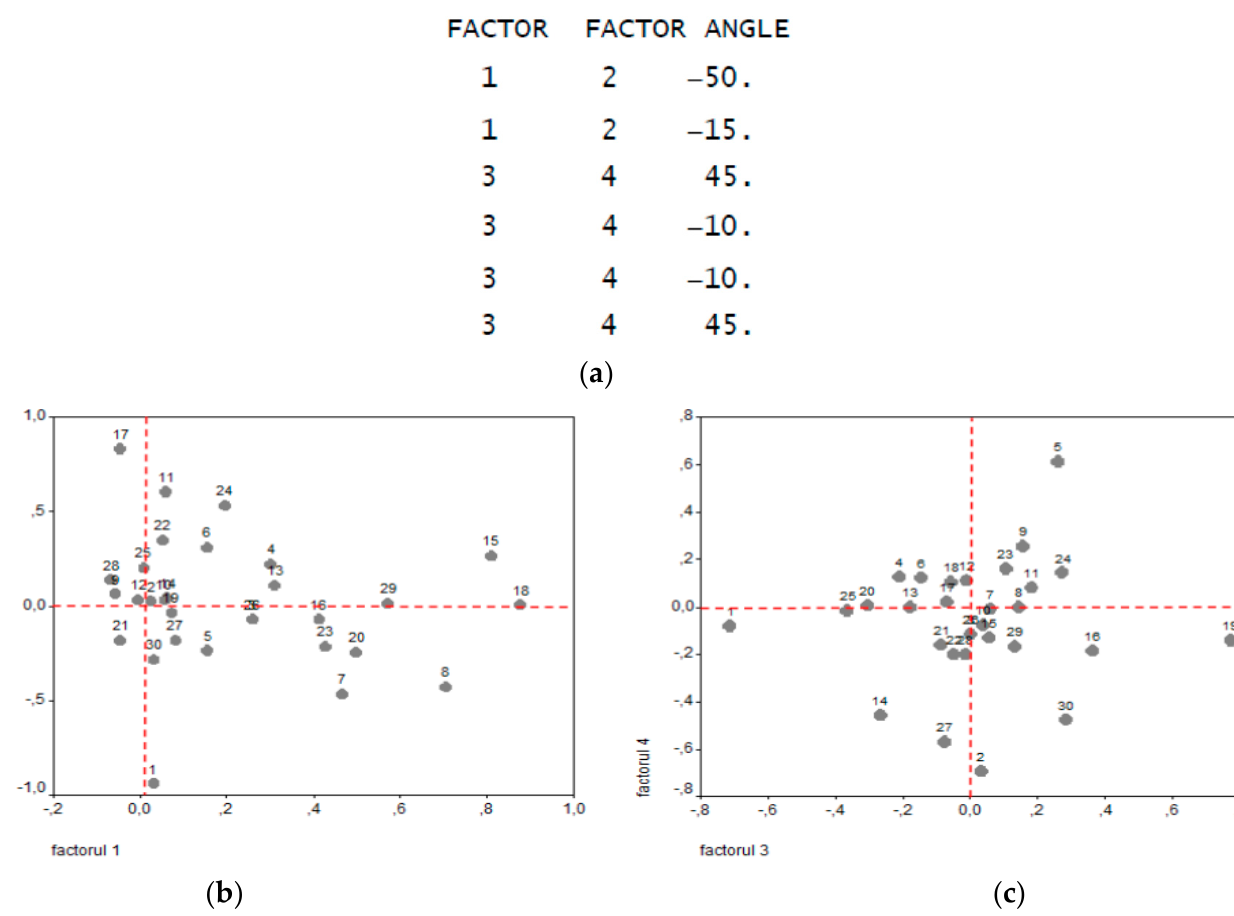
Figure 5. Angles of rotation and distribution of the subjects on the extracted factors ( a ) The angles of rotation; ( b ) The distribution of the subjects on factors 1 and 2; ( c ) The distribution of the subjects on factors 3 and 4.